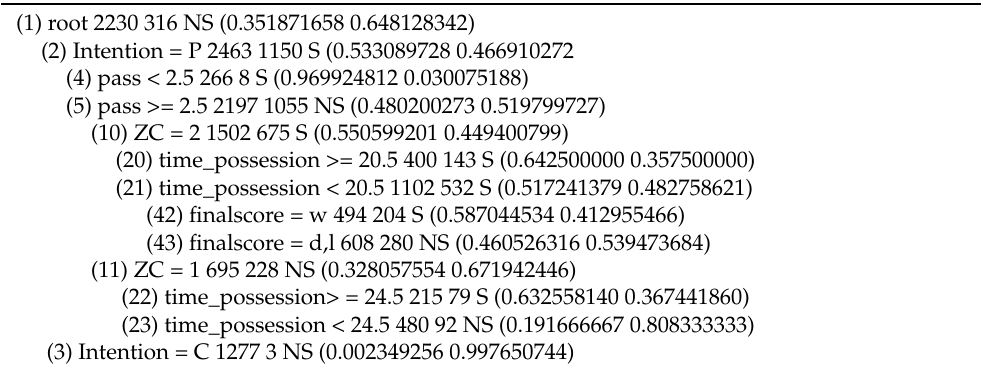
Table 4. Theoretical model